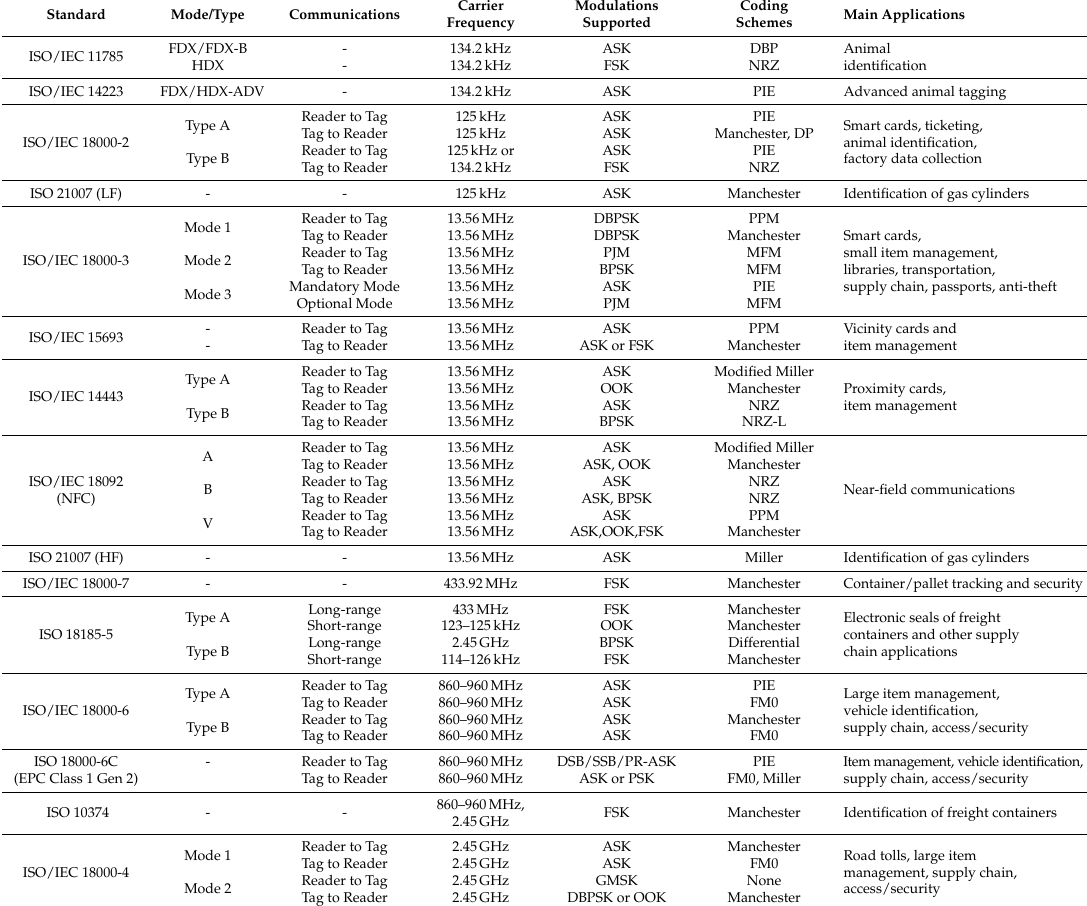
Table 1. Physical layer characteristics of the most relevant RFID